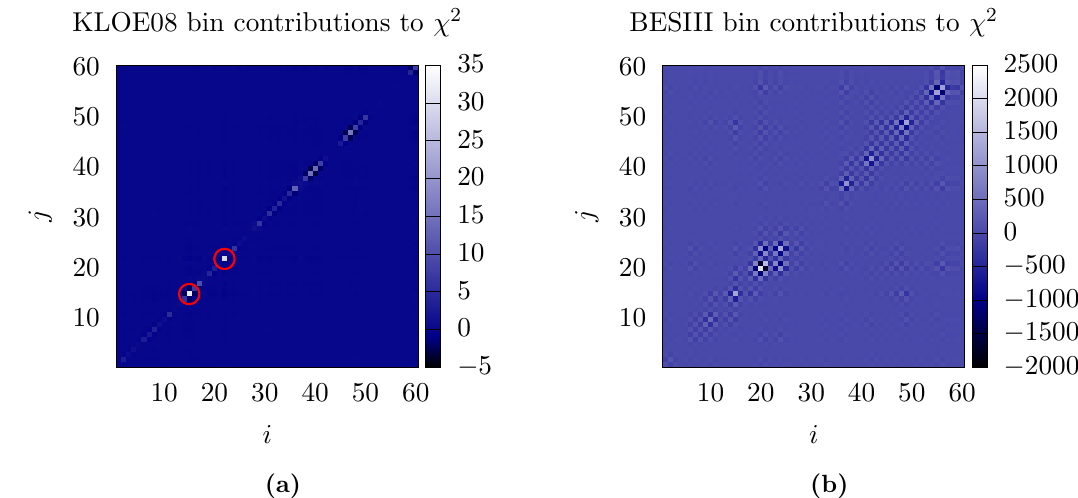
Figure 6. (a) Individual bin contributions to the (cid:31) 2 in the KLOE (cid:12)t, restricted to the 60 bins of KLOE08. Bins #15 and #22 appear as outliers and are marked by red circles. (b) Individual bin contributions to the (cid:31) 2 in the BESIII (cid:12)t. There are huge positive and negative contributions and it is not possible to identify single